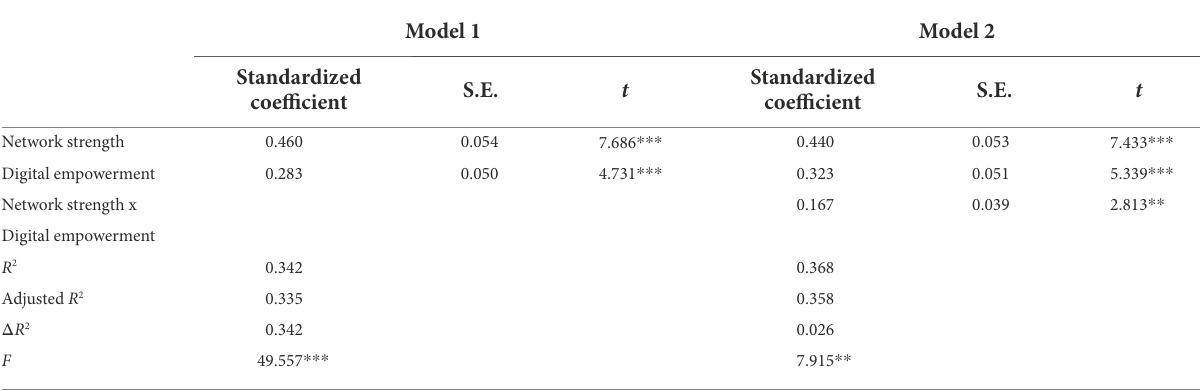
TABLE 11 Test results of the moderating effect of digital empowerment between cluster innovation network strength and innovation performance.